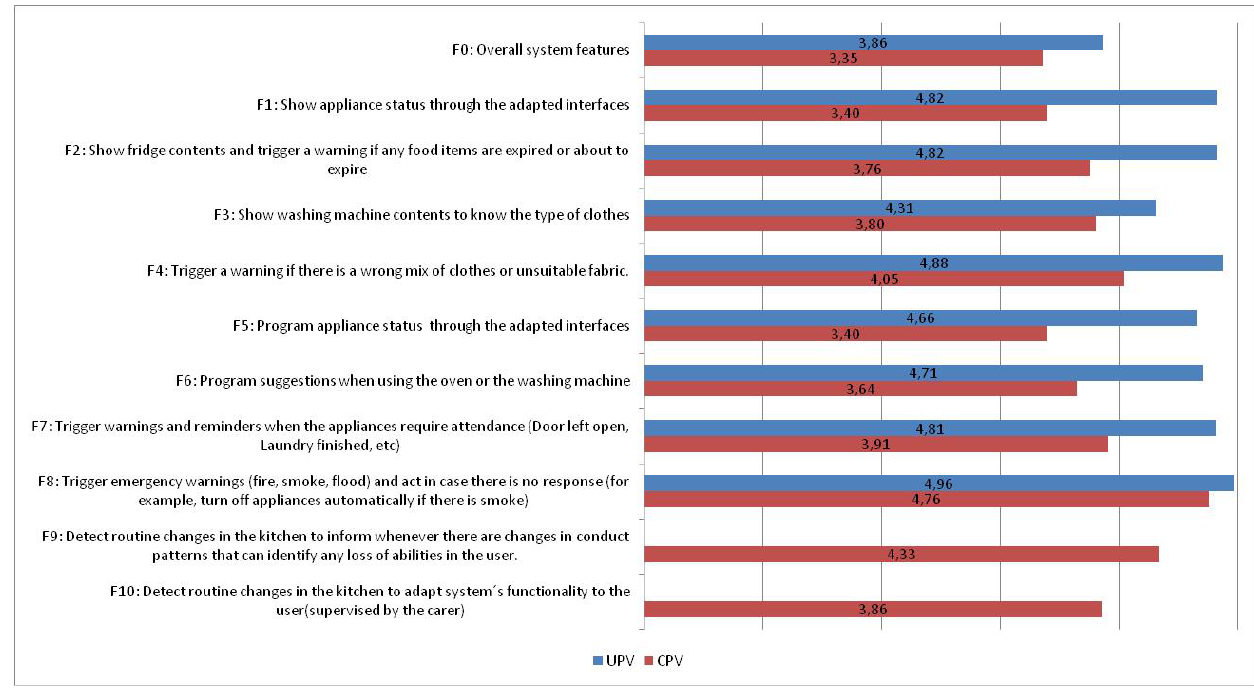
Figure 11. Functionalities of the e-Servant evaluated by the caregivers (Caregivers Point of View, CPV) and for the users (Users Point of View,